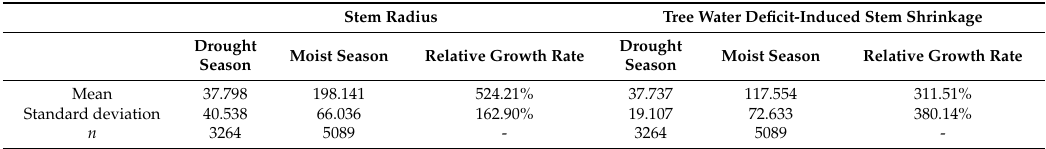
Table 1. The means and standard deviations of stem radius and tree water deficit-induced stem shrinkage in two stages: drought season (11 April to 17 June) and moist season (18 June to 1 October).